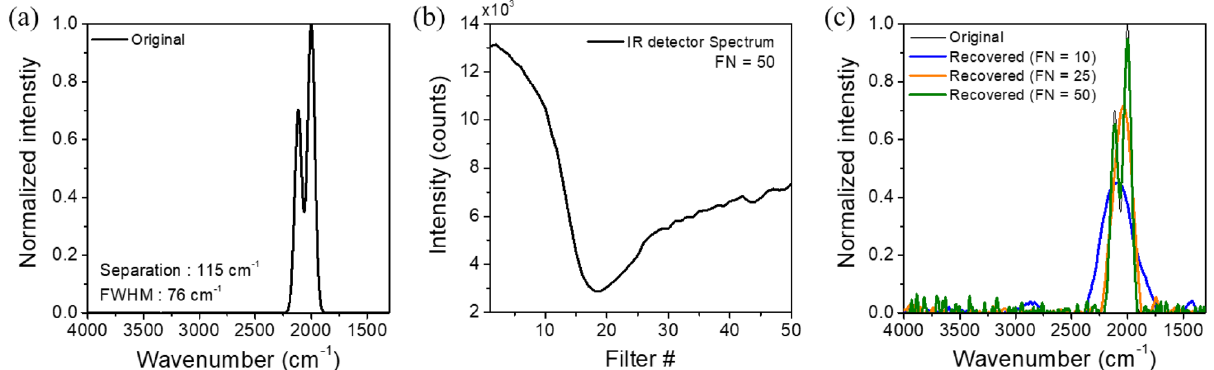
Figure 7. ( a ) Target spectrum consisting of a doublet of two Gaussian peak curves with an FWHM of 76 cm −1 and separated by 115 cm −1 from each other, ( b ) intensity profile measured from 1D IR detector array when the number of filters (FN) = 50, and ( c ) recovered spectra with different FN using Tikhonov